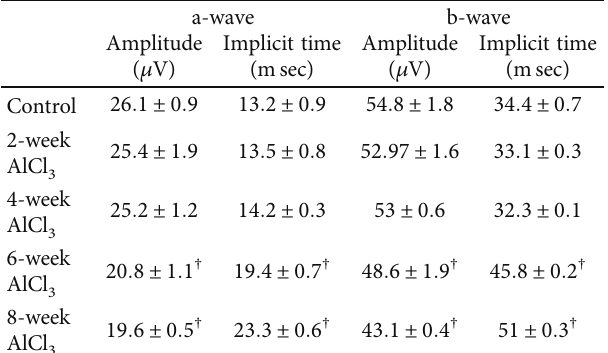
Figure 1: The ERG responses of the dark-adapted eyes for the control group and rats administrated aluminium chloride for 2, 4, 6, and 8 weeks. Table 1: The amplitude ( μ V) and the implicit time (m sec) for a- and b-wave to all groups administrated aluminium chloride compared to control. The data were expressed as the mean ± SD